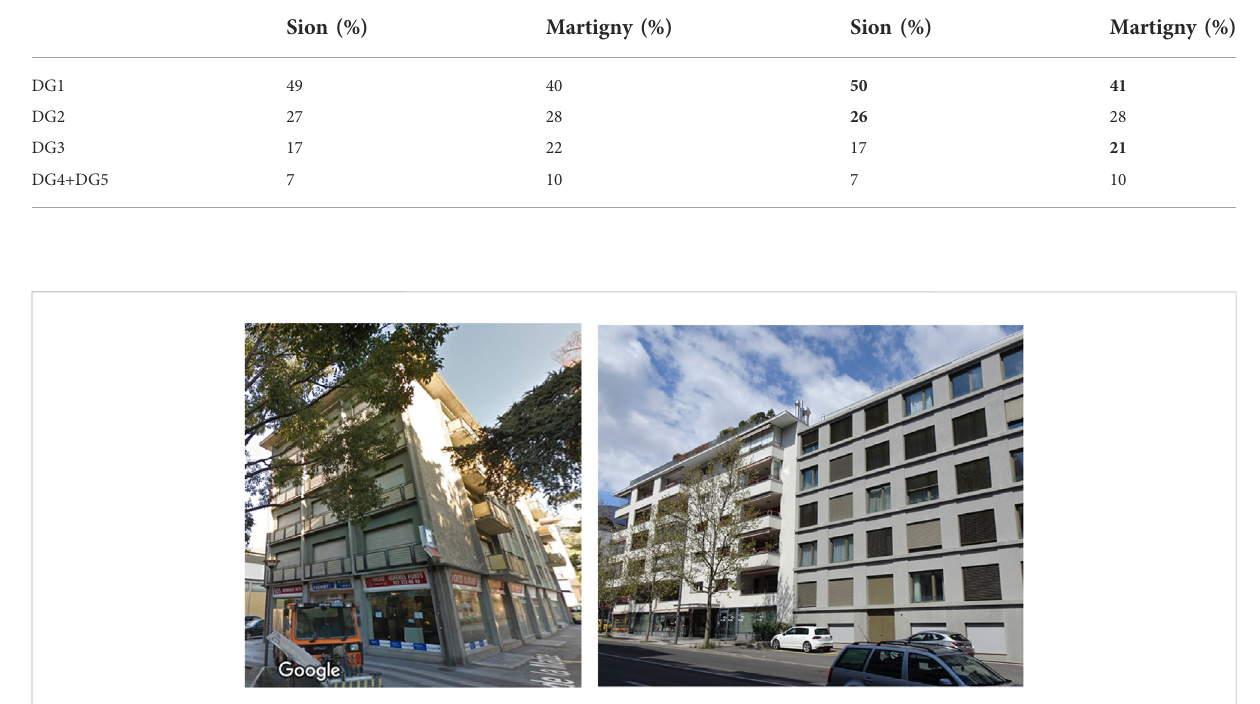
FIGURE 15 Seismic vulnerability may locally be impacted: decreased when a typical soft-story building is demolished (A) or increased when a seismic separation joint is lacking between adjacent buildings with different story levels (B)